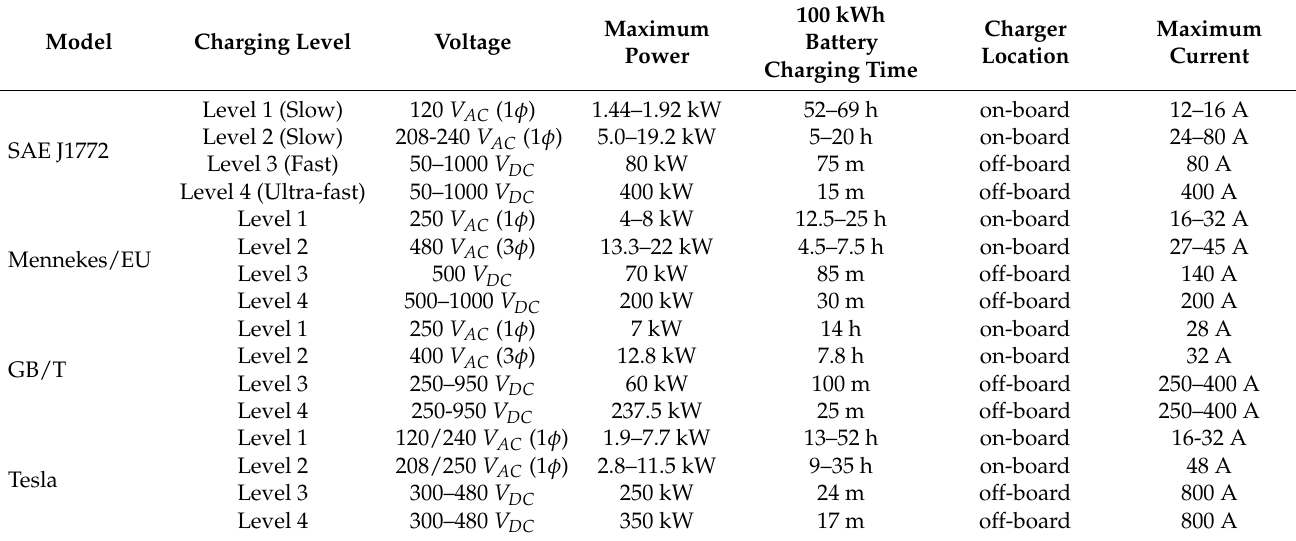
Table 2. Characteristics of battery charging connectors.